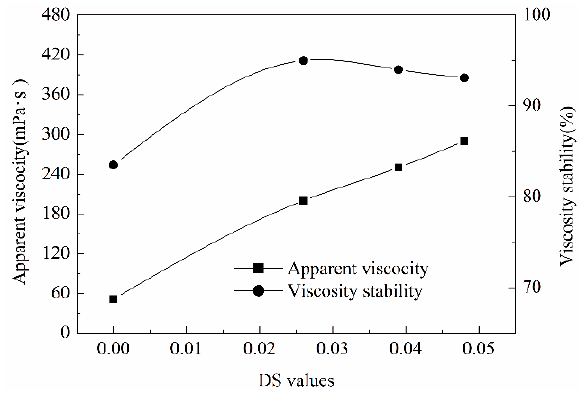
Figure 4. Apparent viscosity and its stability of gelatinized QHOTS paste.